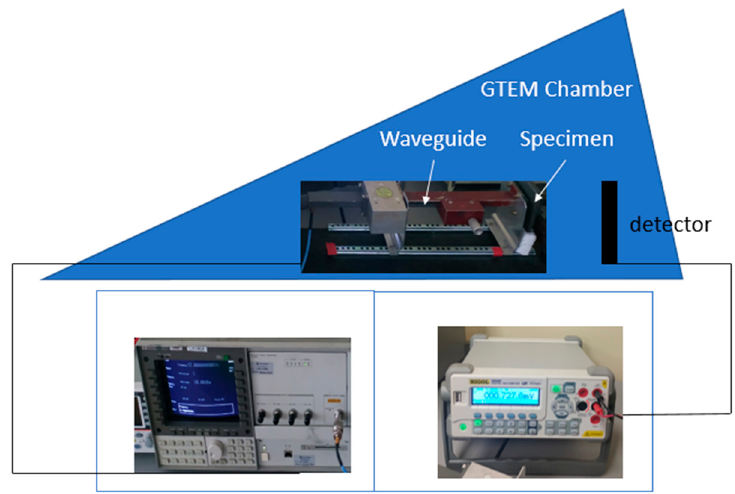
Figure 17. View of the shielding effectiveness measuring stand.